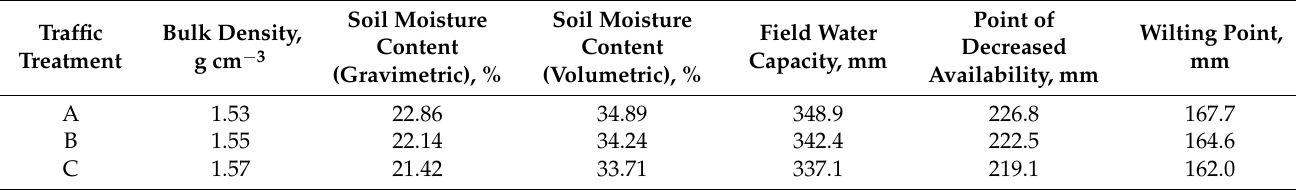
Table 3. Calculated soil water limits in the monitored locations.